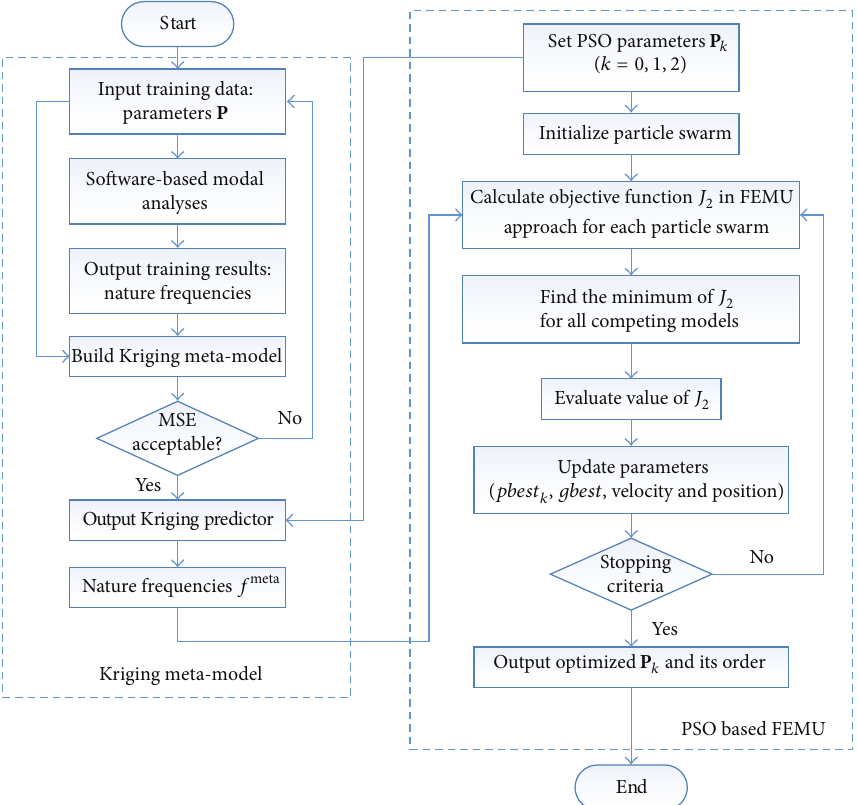
Figure 1: Flow chart of Kriging meta-model (left dashed block) and particle swarm optimization based finite element model updating (right dashed